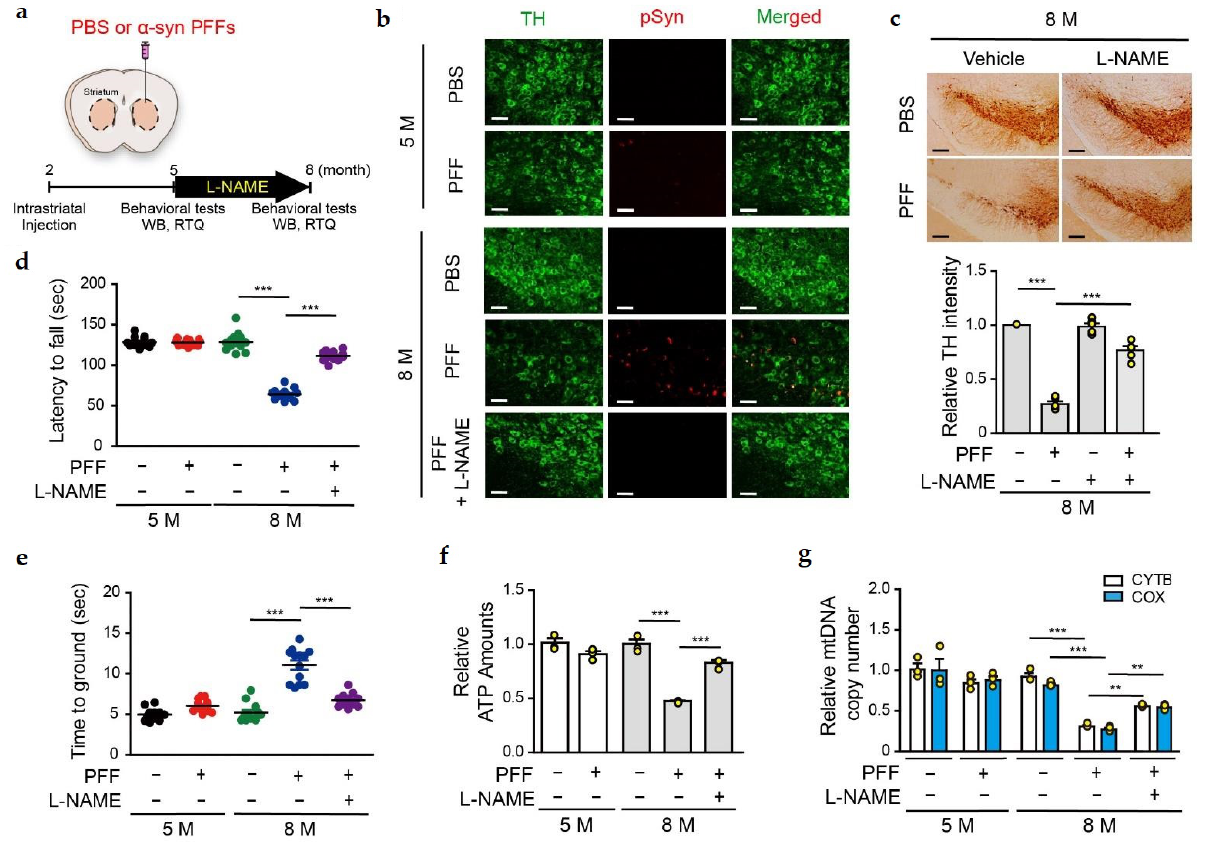
Figure 5. Nitrosative stress is responsible for DA neuronal cell death and motor dysfunction in α -syn PFFs injected sporadic PD mouse model. ( a ) Study design for intrastriatal PBS or α -syn PFFs injection. α -syn PFFs ( 5 μg /mouse) were stereotaxically injected into the striatum of C57BL/6 mice at the indicated time. L-NAME administration and behavioral testing were performed, as indicated in the timeline. All mice were sacrificed after the final behavioral experiments. ( b ) Representative immunofluorescence images showing TH (green) and phospho- α -syn (red) expression in the SN region of α -syn PFFs injected mice. Scale bar = 50 µ m. ( c ) Representative images showing TH staining of the midbrain sections from the SN region of PBS- or α -syn PFFs-injected mice, with or without L-NAME treatment (6 months post-injection). Scale bar = 200 µ m. Bottom panel, relative TH intensity in all mice groups evaluated using the imageJ software. n = 5, One-way ANOVA followed by Tukey’s multiple comparison test, *** p < 0.001. ( d ) Pole test of PBS- or α -syn PFFs-injected mice treated with L-NAME at the age of 5 and 8 months. n = 13 per group. Two-way ANOVA followed